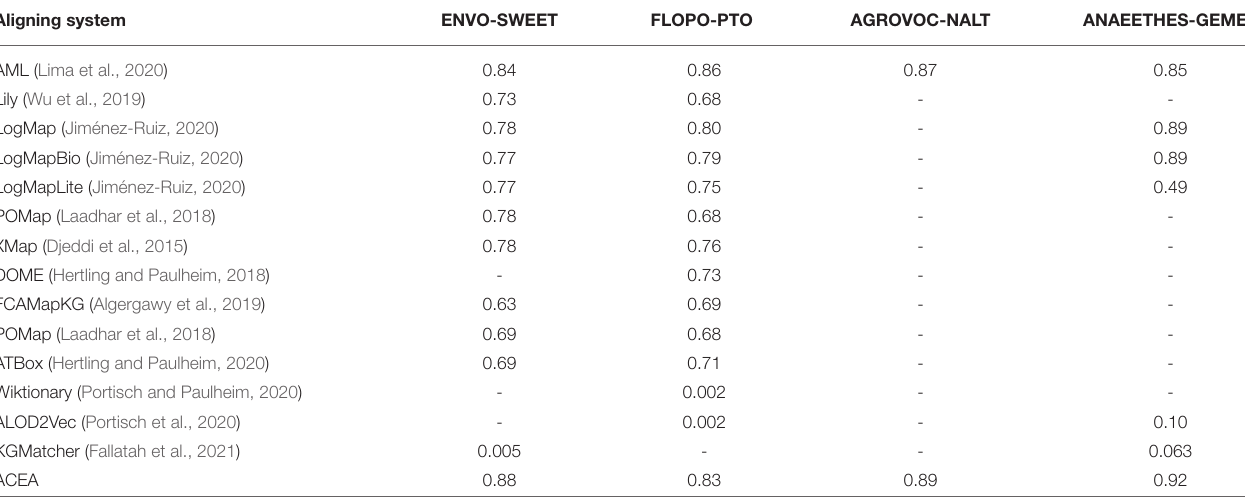
TABLE 4 | Comparisons among ACEA and state-of-the-art ontology aligning techniques in terms of f-measure. Aligning